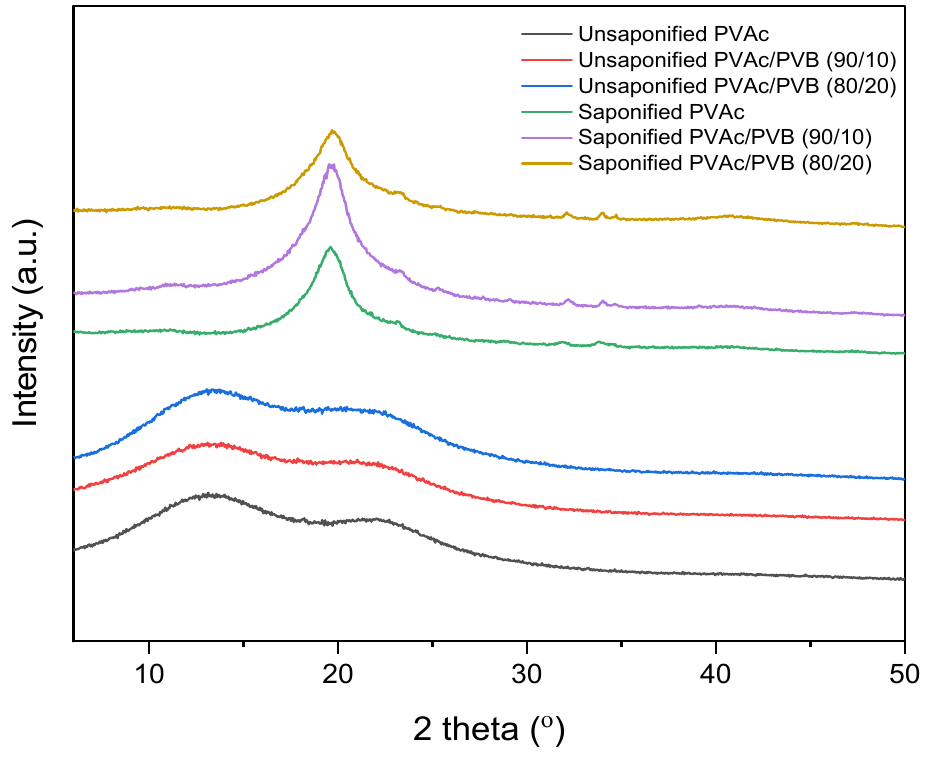
Figure 4. XRD patterns of unsaponified and saponified PVAc, PVAc/PVB 90/10, and PVAc/PVB 80/20 films.